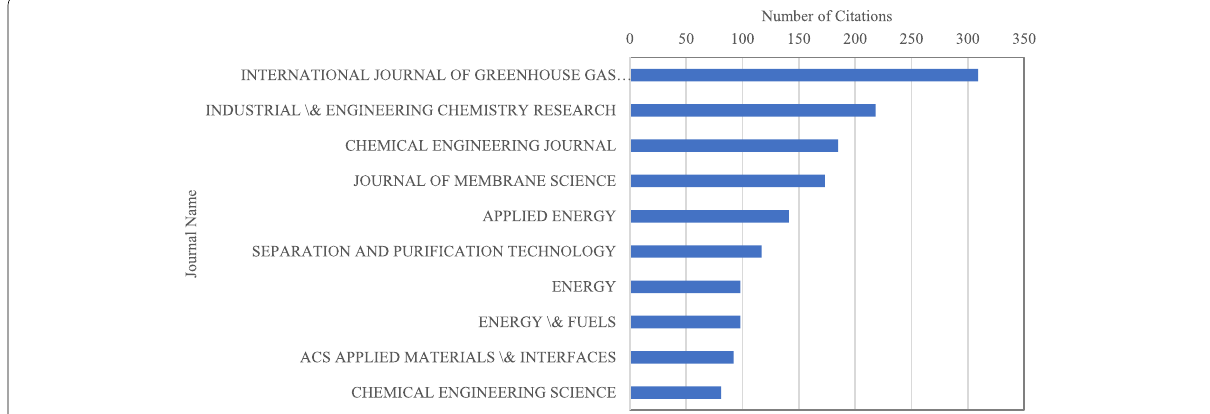
Fig. 12 Combined, no articles produced based on journal